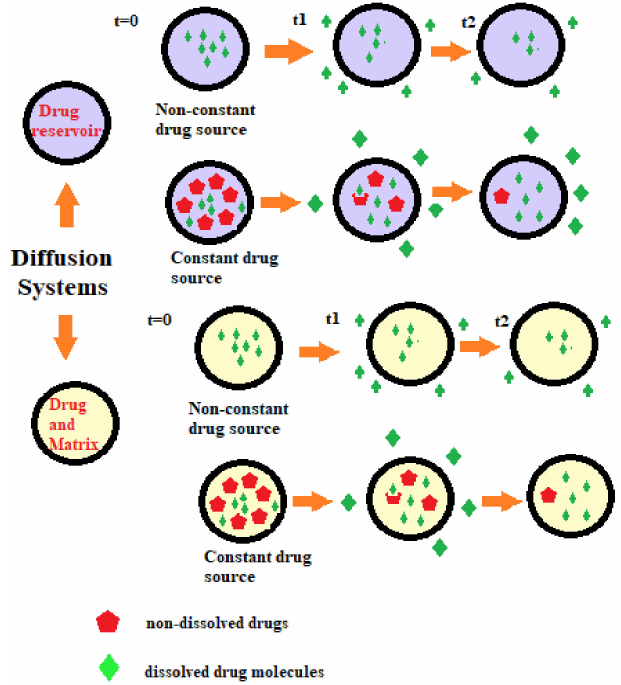
Figure 24. Schematic of diffusion-controlled delivery